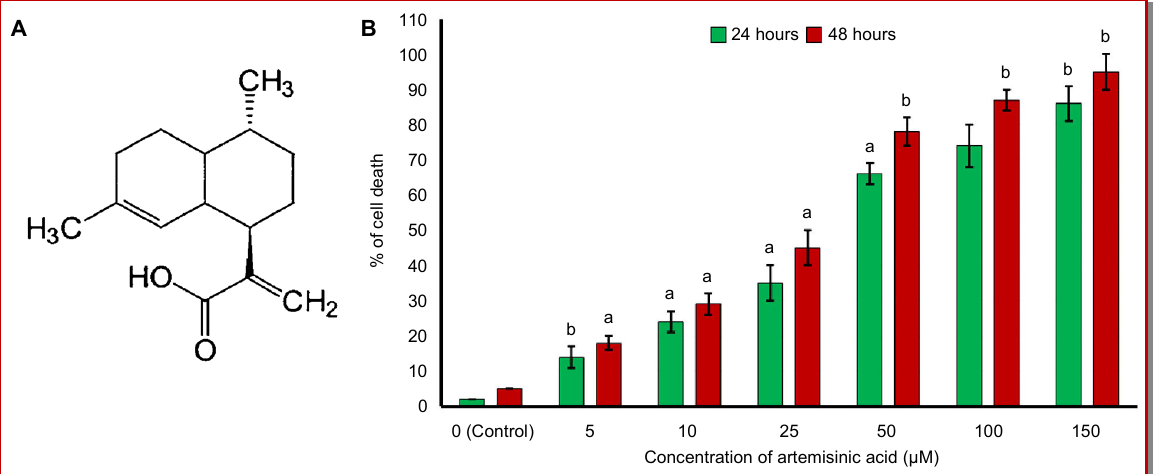
Figure 1: A) Chemical structure of artemisinic acid. B) Cytotoxic effect of artemisinic acid in human breast cancer cells (MCF-7). Data are shown as the mean ± SD of three independent experiments. a p<0.05, b p<0.01, vs 0 µM (control)